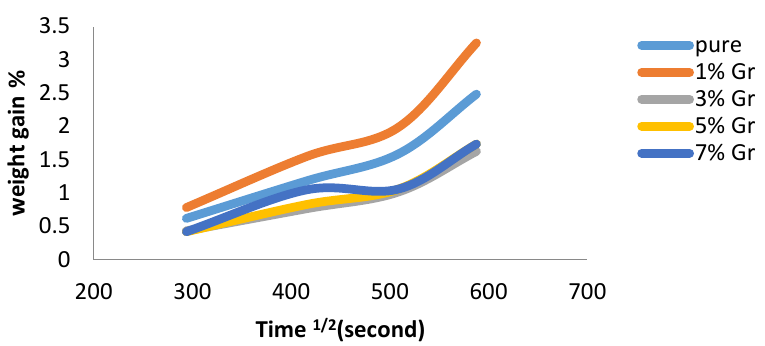
Figure 5: Weight gain as a function of time for blend (Eboxy resin and Repcoat ZR)/Gr.